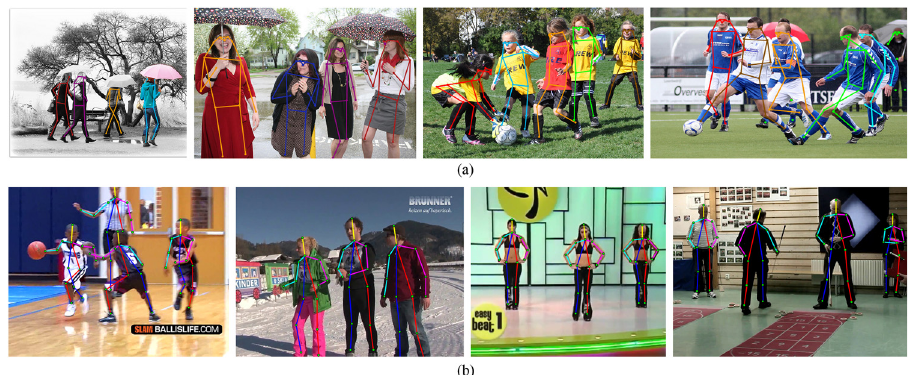
Figure 9: Visualization of conventional poses. ( a ) Visualization of inference results of COCO data set. ( b ) Visualization of inference results of MPII data